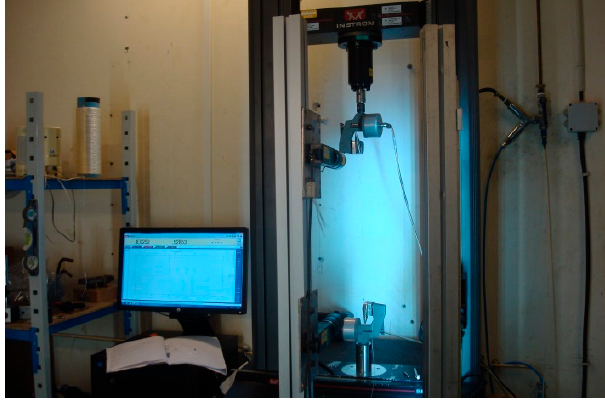
Figure 3. Hybrid yarn tensile test set-up.